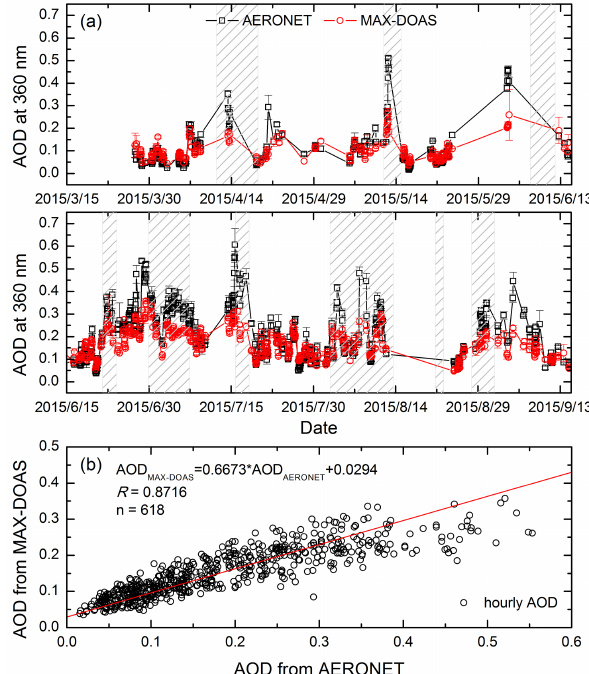
Figure 4. Time series of the AODs at 360nm retrieved from MAX- DOAS and